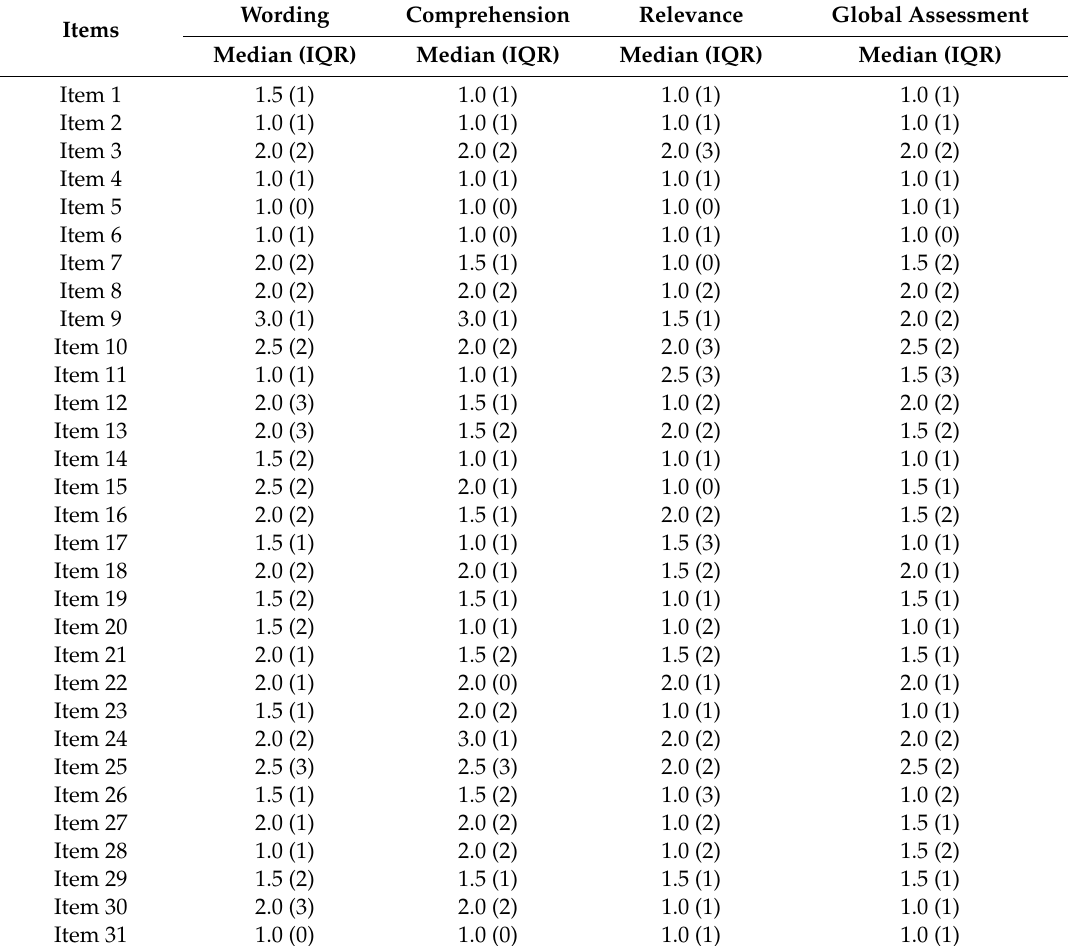
Table 1. Evaluation of the items by the